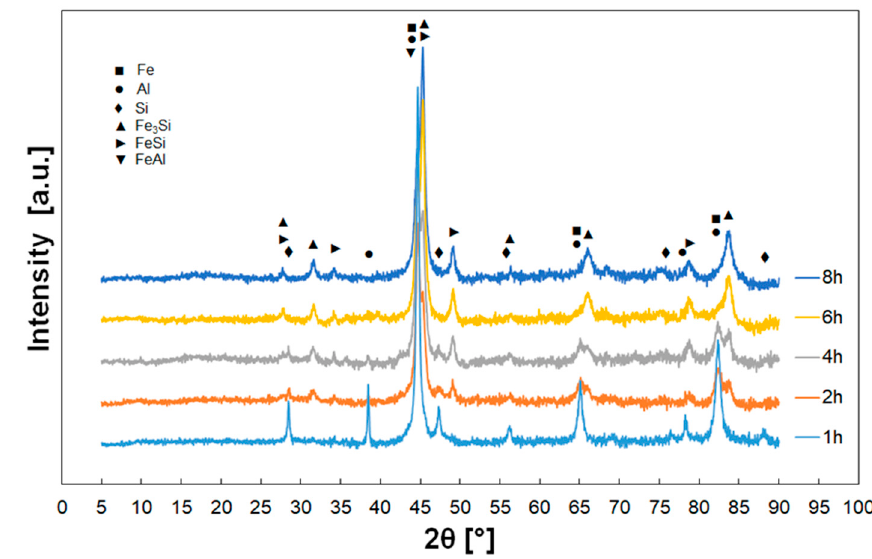
Figure 6. Typical example of the phase composition evolution with increasing time of mechanical alloying (Fe_AlSi powder mixture).